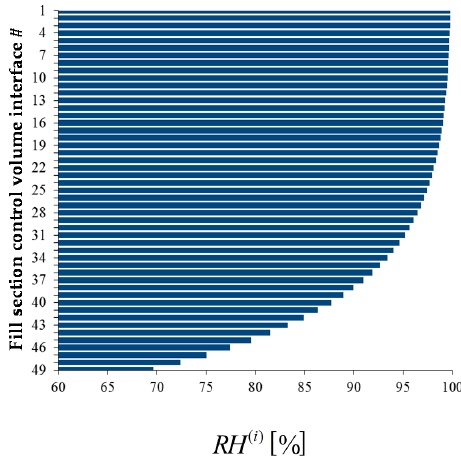
Figure 6. Bar plot of the outlet air temperature T ( ) i volume along the height of the fill section of the cooling.